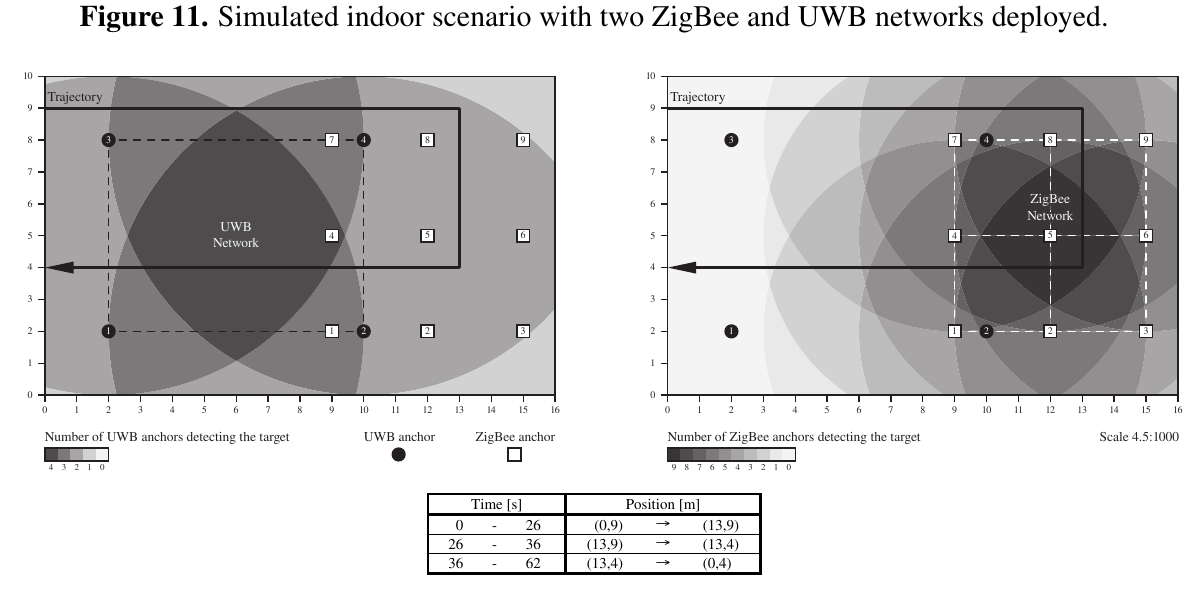
Figure 11. Simulated indoor scenario with two ZigBee and UWB networks deployed.